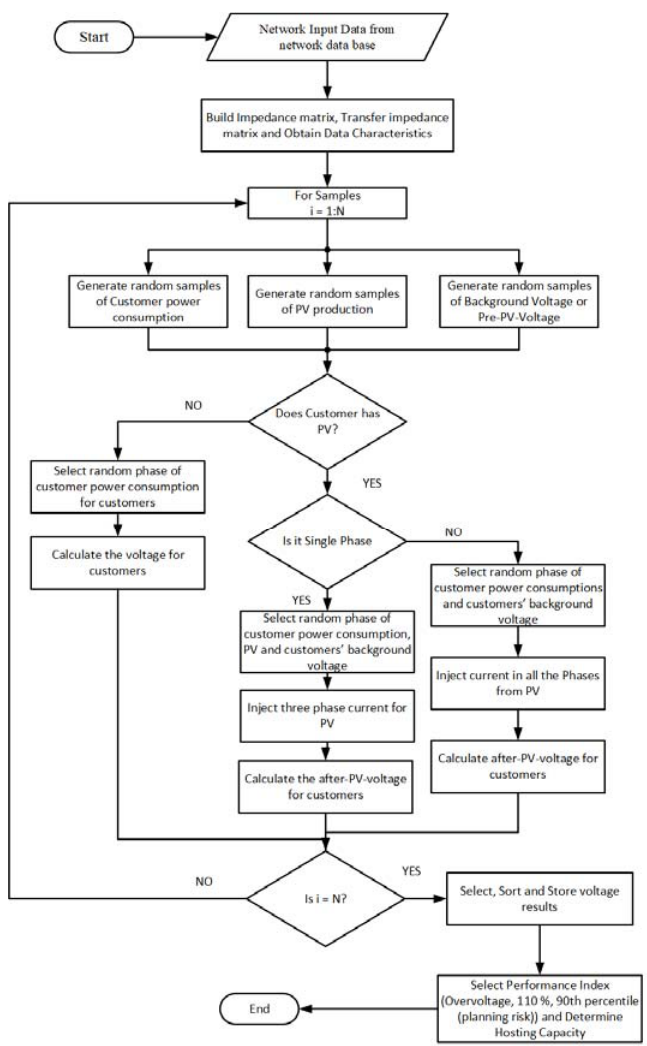
Figure 1. The flow chart for the stochastic hosting capacity approach in a distribution network for single-phase and three-phase solar